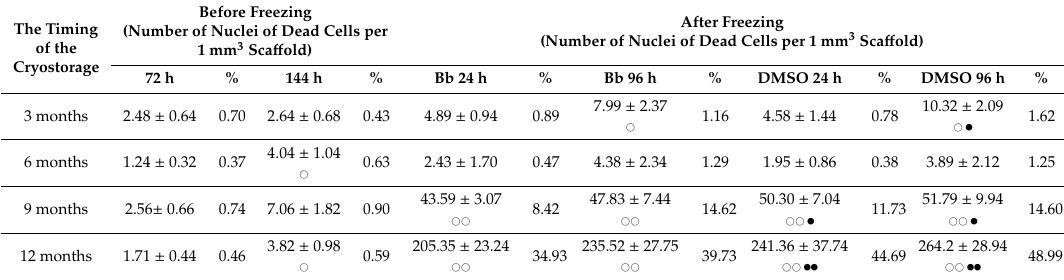
Table 2. The number of dead cells in sca ff olds before and after di ff erent cryostage periods. The Timing of the